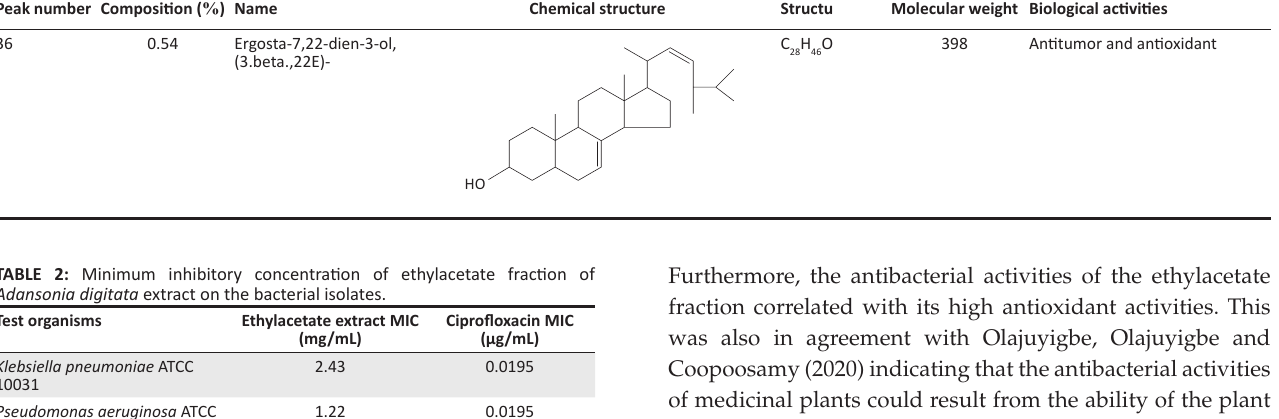
TABLE 1 (Continues...): Chemical compounds in ethylacetate extract of Adansonia digitata identified by gas chromatography–mass spectrometry. Peak number Composition ( % )